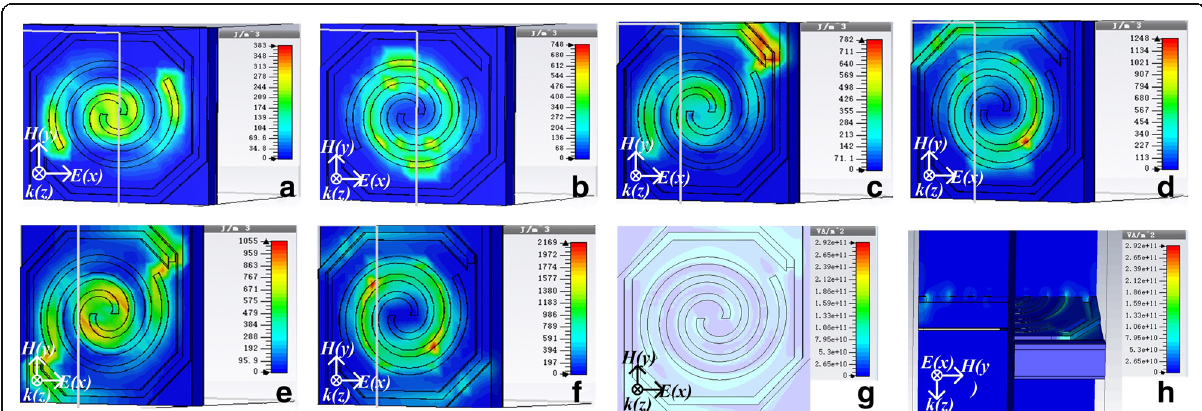
Fig. 6 Distribution of electric field energy density, magnetic field energy density, and power loss. Energy density diagrams of electric field ( a ) and magnetic field ( b ) for spiral-type antenna on the support layer when n = 1.6; energy density diagrams of electric field ( c ) and magnetic field ( d ) for spiral-type antenna with a single separate linear antenna when n = 1.6 and i = − 2; energy density diagrams of electric field ( e ) and magnetic field ( f ) for spiral-type antenna with two separate linear antennas when n = 1.6 and i = − 2; power loss distribution in the micro-bridge structure coupled with spiral-type antenna with two separate linear antennas when n = 1.6 and i = − 2 from top view ( g ) and side view ( h )